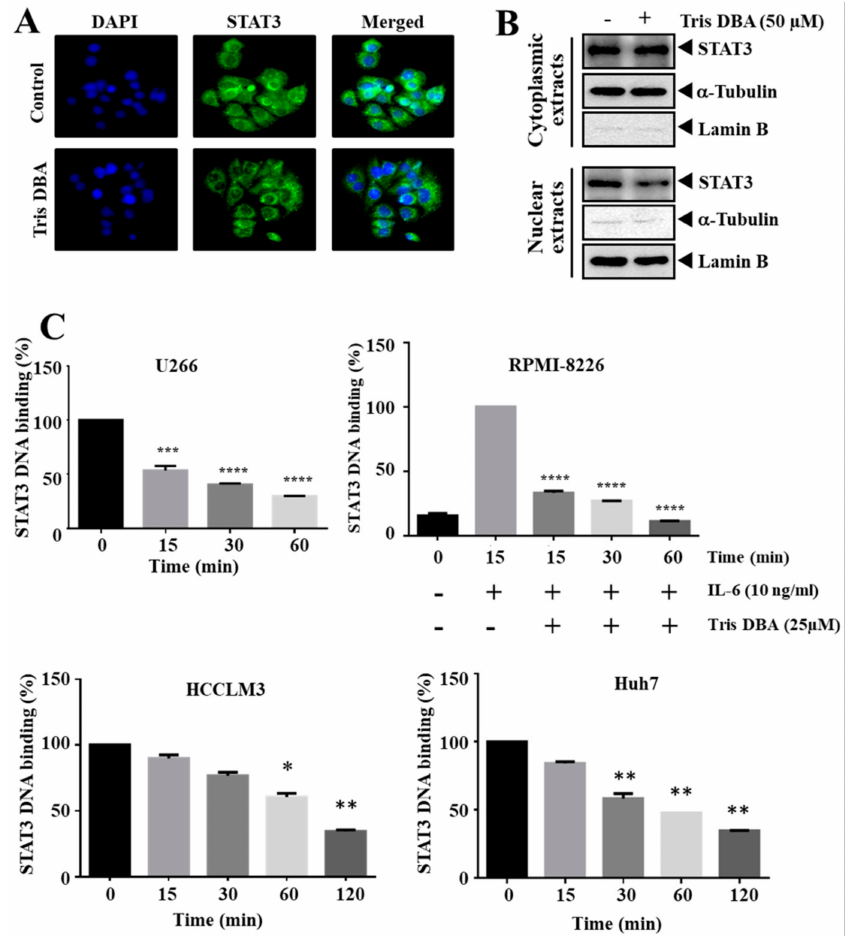
Figure 3. Tris DBA downregulates nuclear STAT3 and its DNA binding ability. ( A ) HCCLM3 cells were treated with Tris DBA (50 µ M) and examined for the cellular compartmentalization of STAT3 by immunocytochemistry. DAPI was used to counterstain and visualize nuclei. ( B ) Cells were treated as described above. Cytoplasmic extracts and nuclear extracts were subjected to western blotting. α -tubulin was used as a loading control for the cytoplasmic extracts and lamin B was used as a loading control for the nuclear extracts. ( C ) MM (U266, IL-6 induced RPMI-8226), and HCC (HCCLM3, and Huh7) cells were incubated with Tris DBA (25 and 50 µ M respectively) and nuclear extracts were prepared to analyze DNA interaction of STAT3 as described in methods. Bars indicate standard deviation; n = 3; * p < 0.05, ** p < 0.01, *** p < 0.001, **** p < 0.0001 versus no